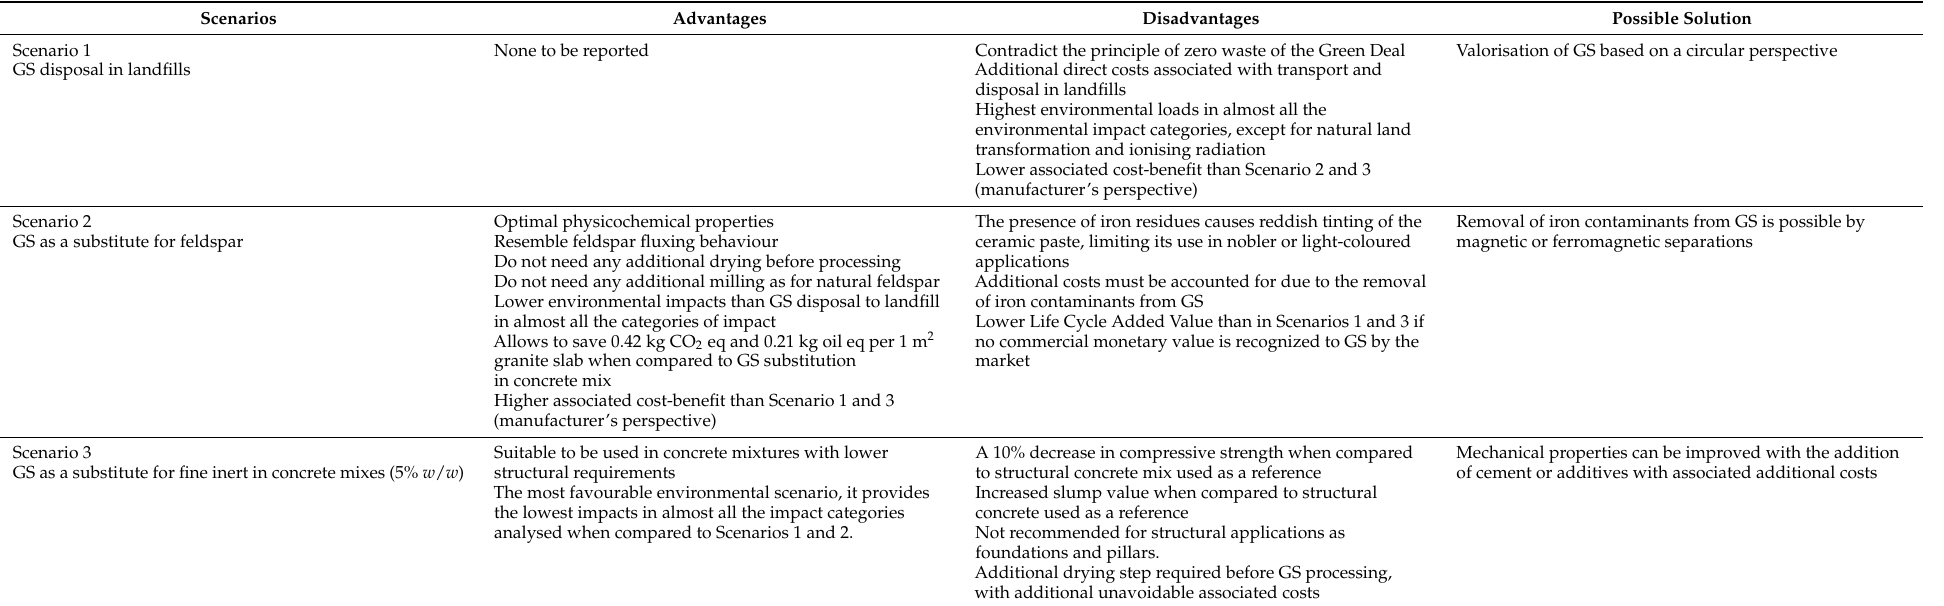
Table 9. Advantages, disadvantages, and possible solutions of the disadvantages for Scenarios